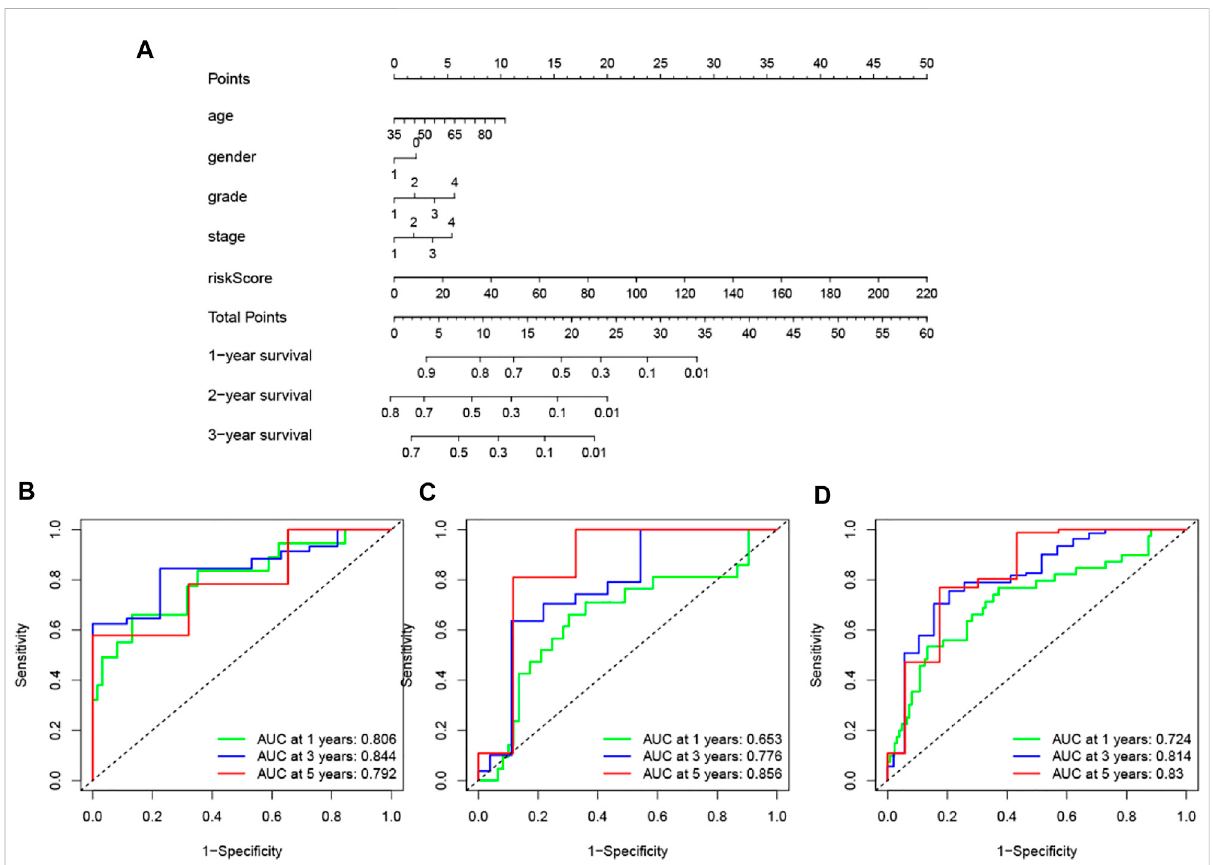
FIGURE 10 Construction and assessment of a nomogram for survival prediction of patients with pancreatic cancer based on risk score, age, gender, pathological grade and stage. (A) The nomogram was established in a training set for predicting 1-, 2-, and 3-years survival of pancreatic cancer patients. (B – D) ROCcurveanalysisfor1-,2-,and3-yearssurvivalpredictionofthenomograminthetrainingset (B) ,testingset (C) ,andTCGAset (D) ,